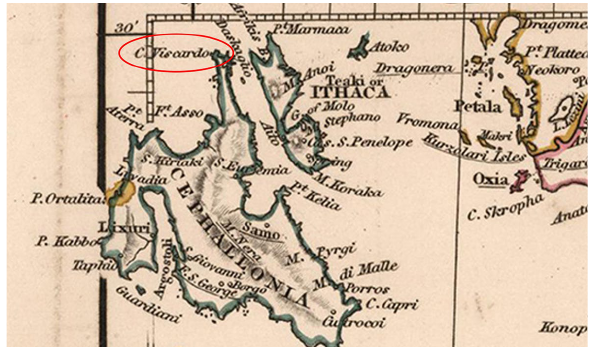
Figure 6 . Arrowsmith, Aaron Jr., Southern Greece, with the adjacent Islands, London, 1828. Detail of the cartography with the island of Fiskardo highlighted in red.